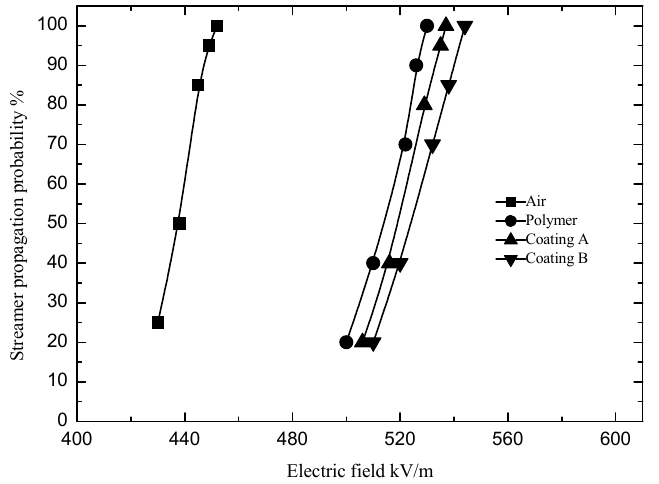
Figure 2. Relationship between the probability of streamer propagation and the guiding electric field. In Formula (1), E is the electric field, E c is the mean value of the electric field; w is the variance; y is the streamer propagation probability; A and y 0 are undetermined coefficients.